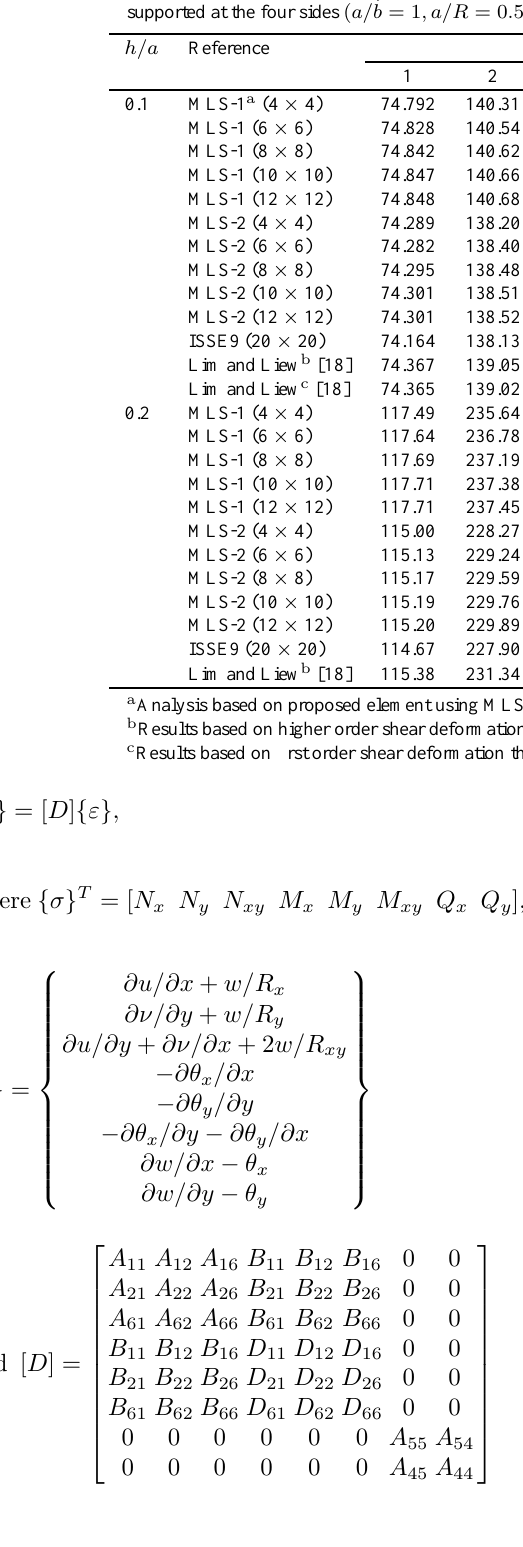
(cid:1) Table 2 ρ/E ) of an isotropic cylindrical shell panel (Fig. 3) simply